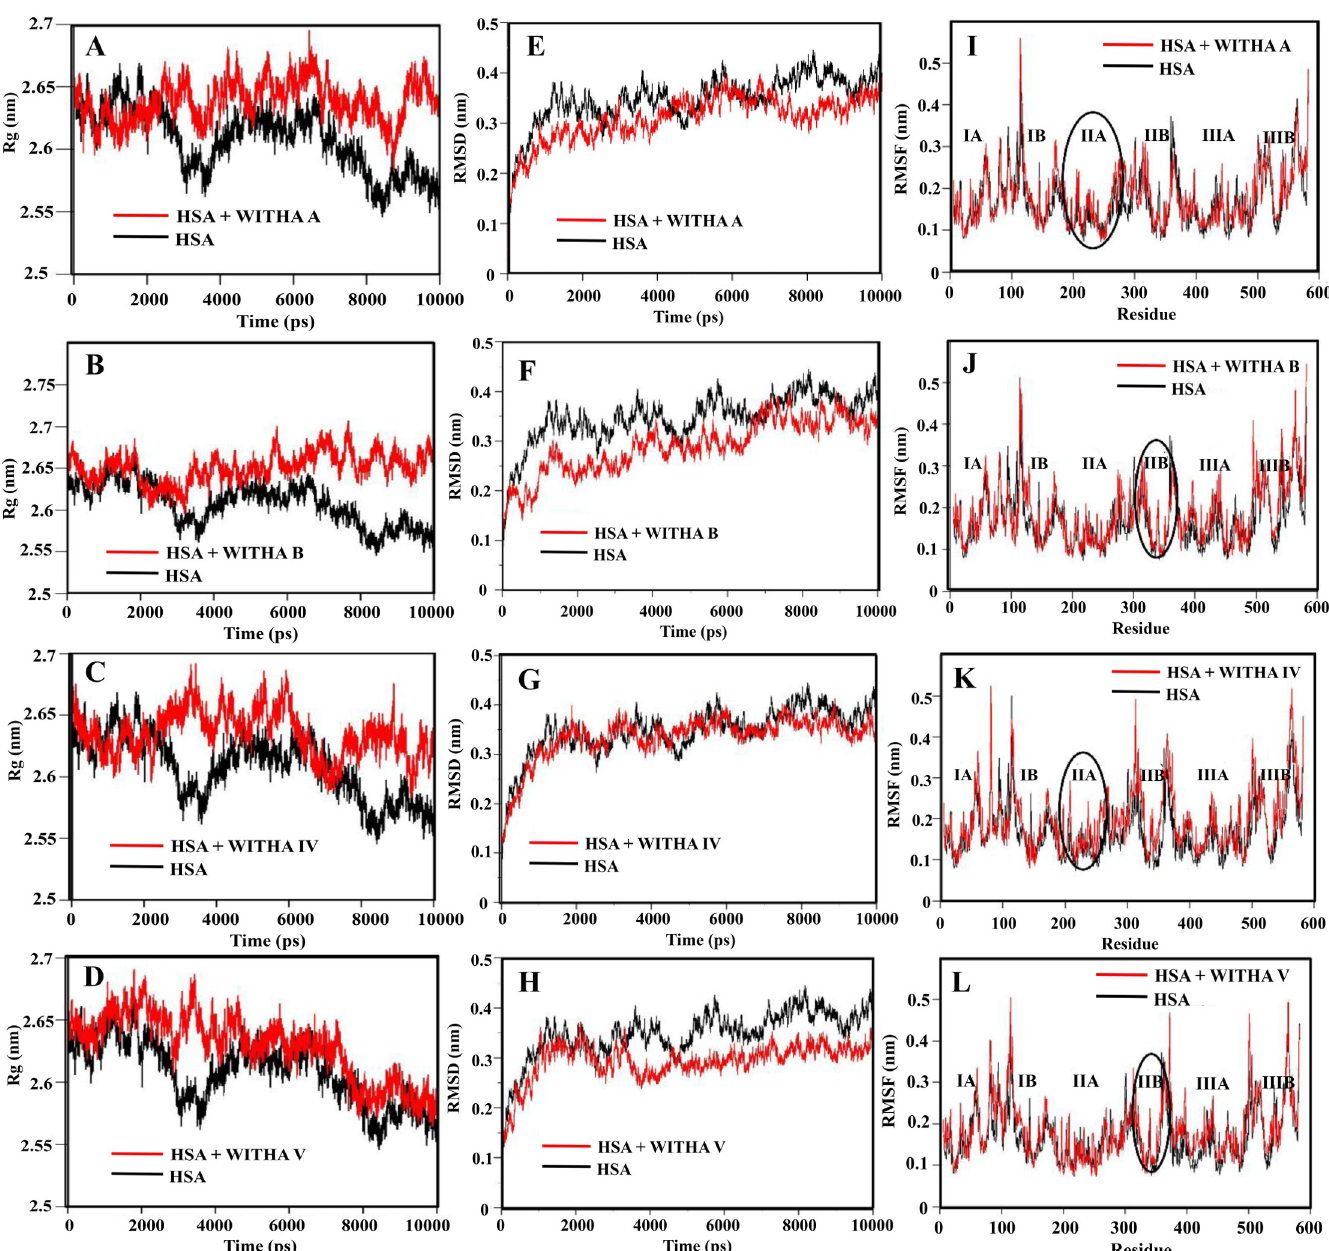
Fig 8. (A-D)-Time evolution of the radius of gyration (Rg) during 10 ns of MD simulation of unliganded HSA and HSA–drug derivatives complexes. (E-H)-Plot of RMSD values for unliganded HSA and HSA–drug derivatives complexes. (I-L)- Comparison of the RMSF of Calcium atoms along the sequence derived from the 10 ns